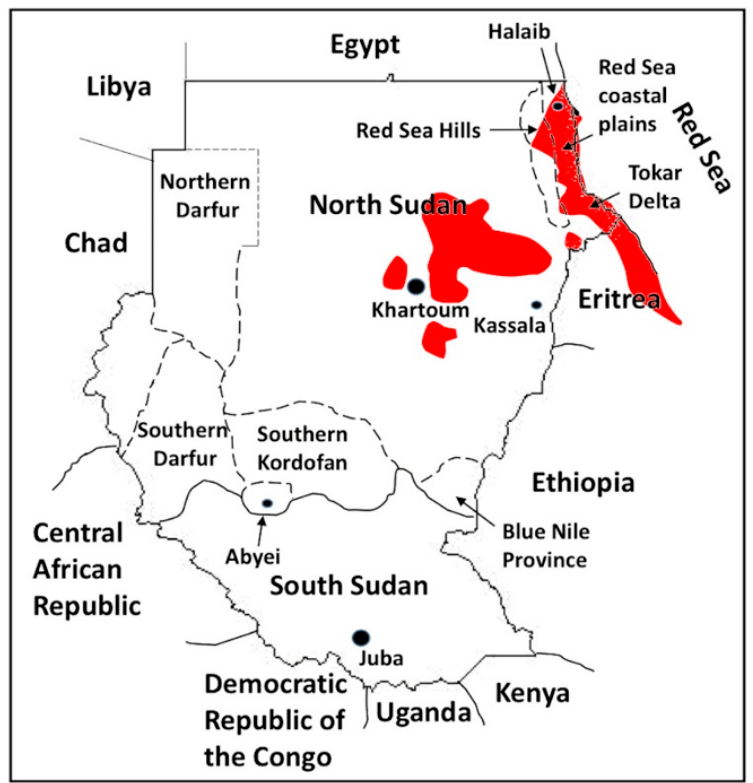
Figure 14. Locations and regions mentioned in the text in relation to desert locust activity and insecurity in North and South Sudan. Primary breeding areas in red. Indirect Insecurity. The government also fought other rebel armies, mostly in the south, following Sudan’s 1956 independence [87,88] through 2020; the largest rebel force was the 40,000-strong Sudan People’s Liberation Army (SPLA) [89]. During peak war years, 2003–2005, the government attacked villages using helicopters and fixed-wing Antonov bombers [90]. Ground forces followed, targeting the Fur, Massalit, and Zaghawa tribes especially in the Darfur provinces (Figure 14) [90]. The military was augmented by the Janjaweed , a militia comprised of former bandits, demobilized soldiers, young tribesmen, and unemployed youths [90]. The aim was ethnic cleansing accomplished through atrocities, killing hundreds of thousands [70,91]. Less than a year after Sudan split into the Republic of (North) Sudan and the Republic of South Sudan (Figure 14) in 2005, the two countries were fighting again [88], and limited conflict in the Darfur provinces erupted into another civil war. Further, in April 2012, war recommenced between North Sudan and South Sudan, with the SPLA crossing into the north and the North Sudan Armed Forces bombing southern villages [88]. In addition, North Sudan fought insurgencies in the South Kordofan, Blue Nile, and Abyei provinces (Figure 14) [88]. Conflict also occurred within South Sudan against the Juba-based government (Figure 14) [88]. In 2014 the president of North Sudan renamed the Janjaweed the Rapid Support Forces (RSF), comprised of ≈ 10,000 fighters, as his personal army to counter diminishing military loyalty [91]. The RSF continued inflicting atrocities, including aerial bombing of civilians in North and South Darfur, South Kordofan, and Blue Nile provinces (Figure 14) [91]. In 2016, in addition to its many other conflicts, the North Sudan government fought the Justice and Equality Movement, two different factions of the Sudan Liberation Movement, and the Liberation and Justice Movement